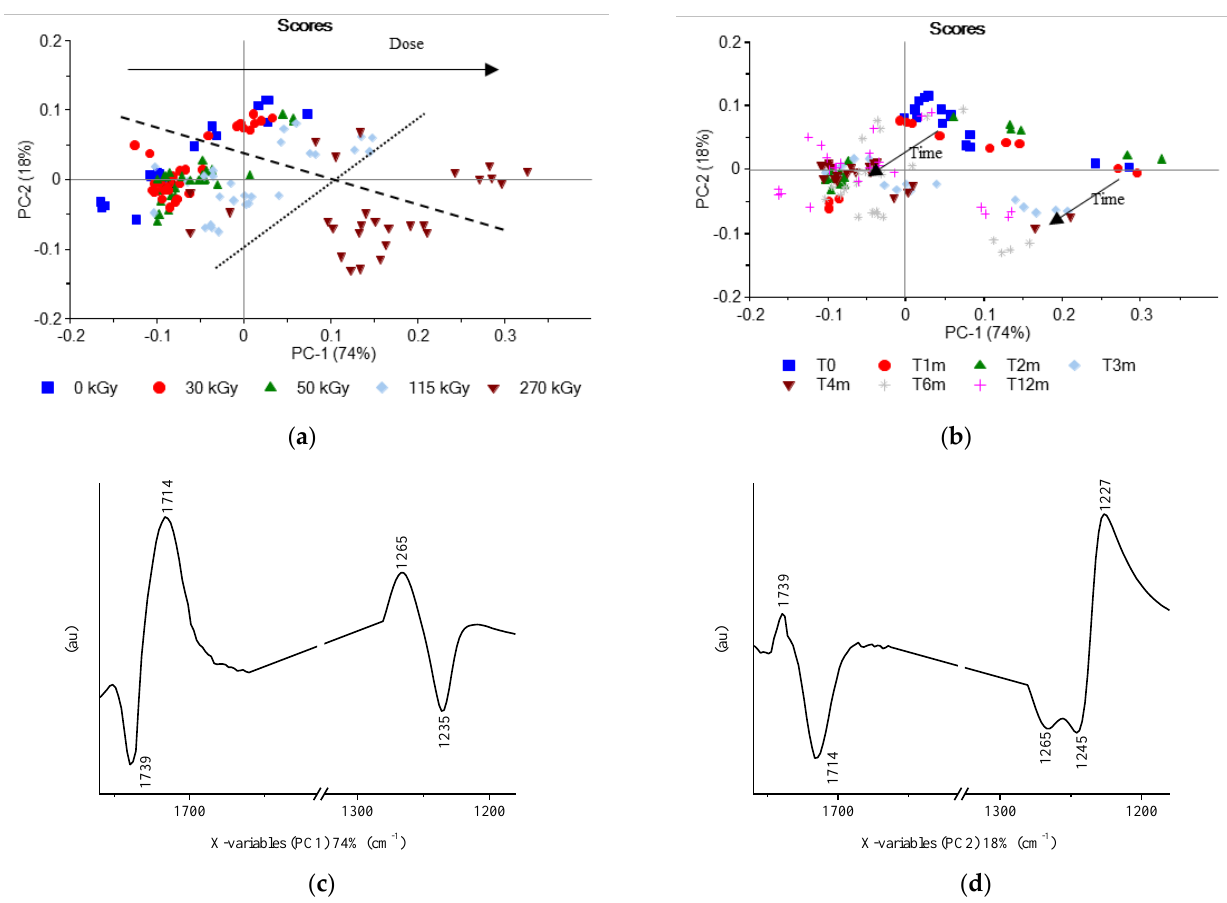
Figure 9 . PCA of EVA spectra at all γ-irradiation doses (1760–1670 cm −1 // 1280–1180 cm −1 ). Spectra are baseline corrected and normalized. ( a ) Score plot of PCA with γ-dose labels. Dashed line delimits the ageing groups and dotted line delimits the γ-doses groups. ( b ) Score plot of PCA with time labels. ( c ) Loading plot of PC1. ( d ) Loading plot of PC2. Reproduced from [28] with the permission of Polymer Degradation and Stability.